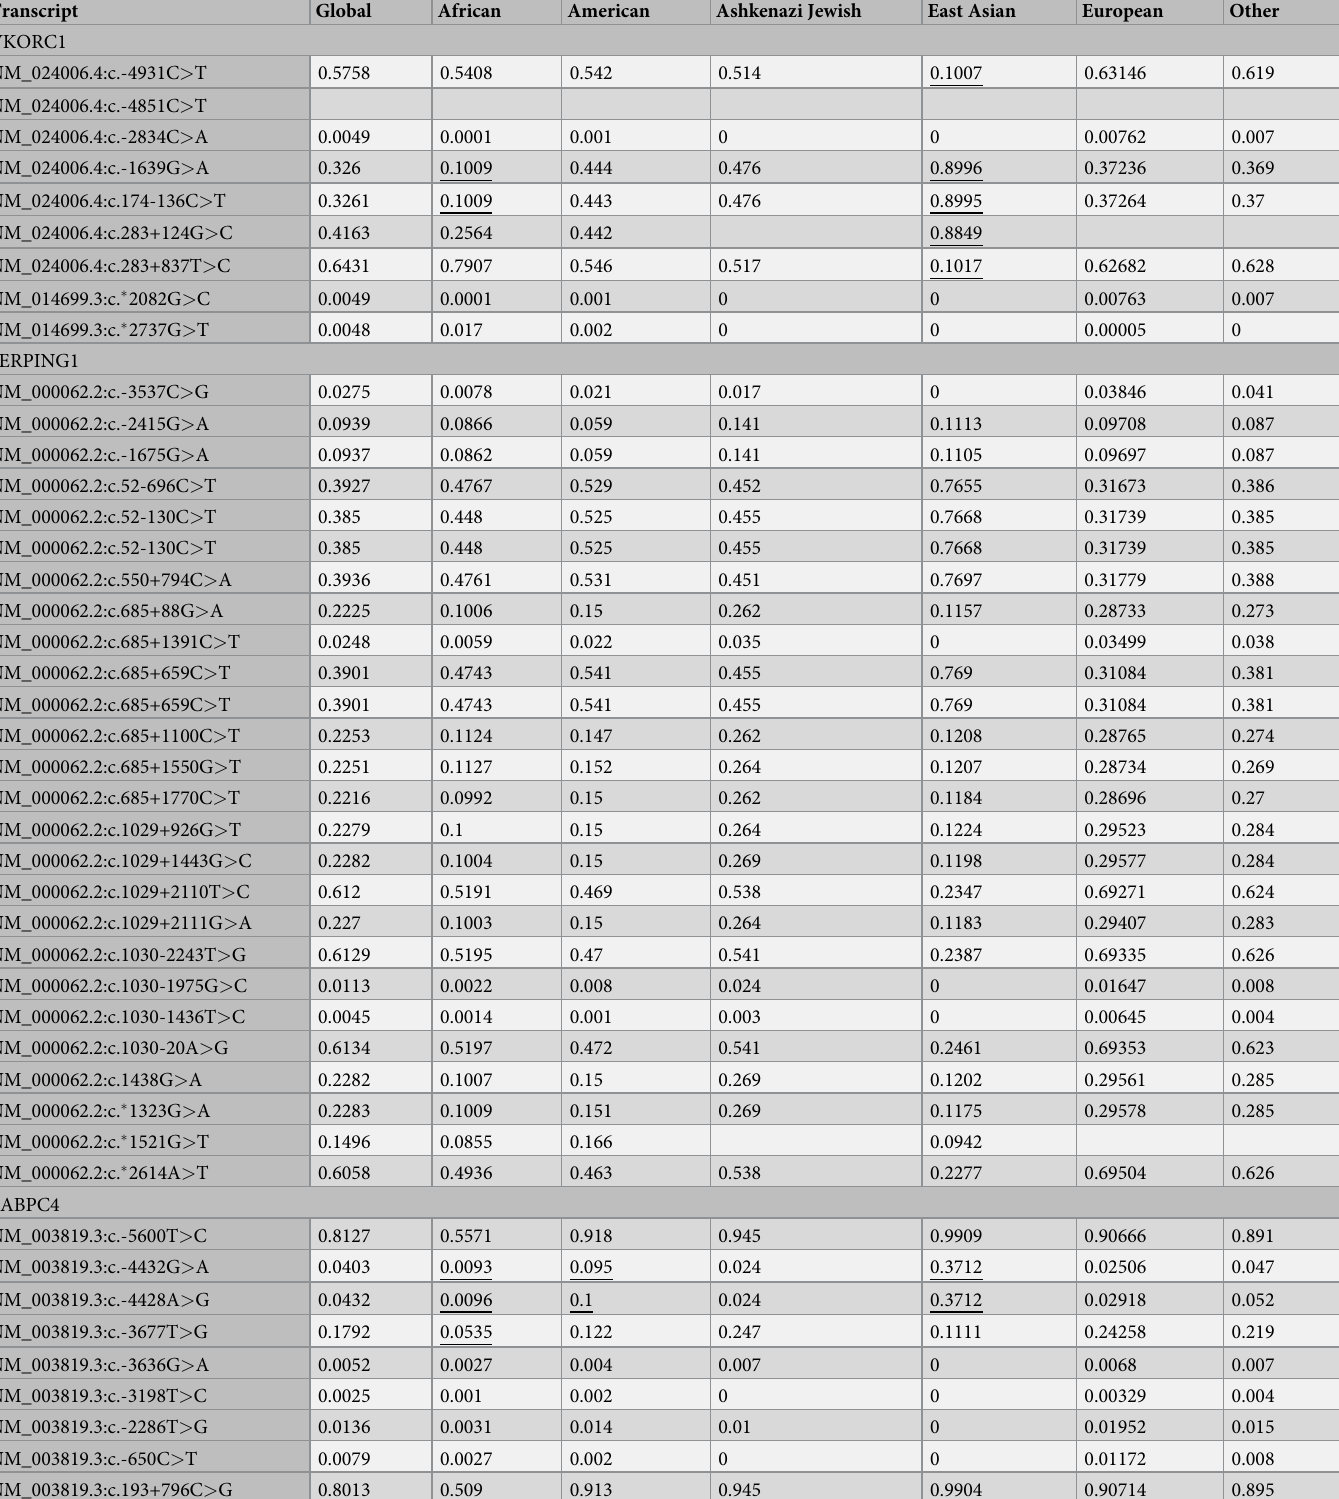
Table 3. Population frequencies (gnomAD) of GWAS variants of VKORC1, SERPING1, and PABPC4.